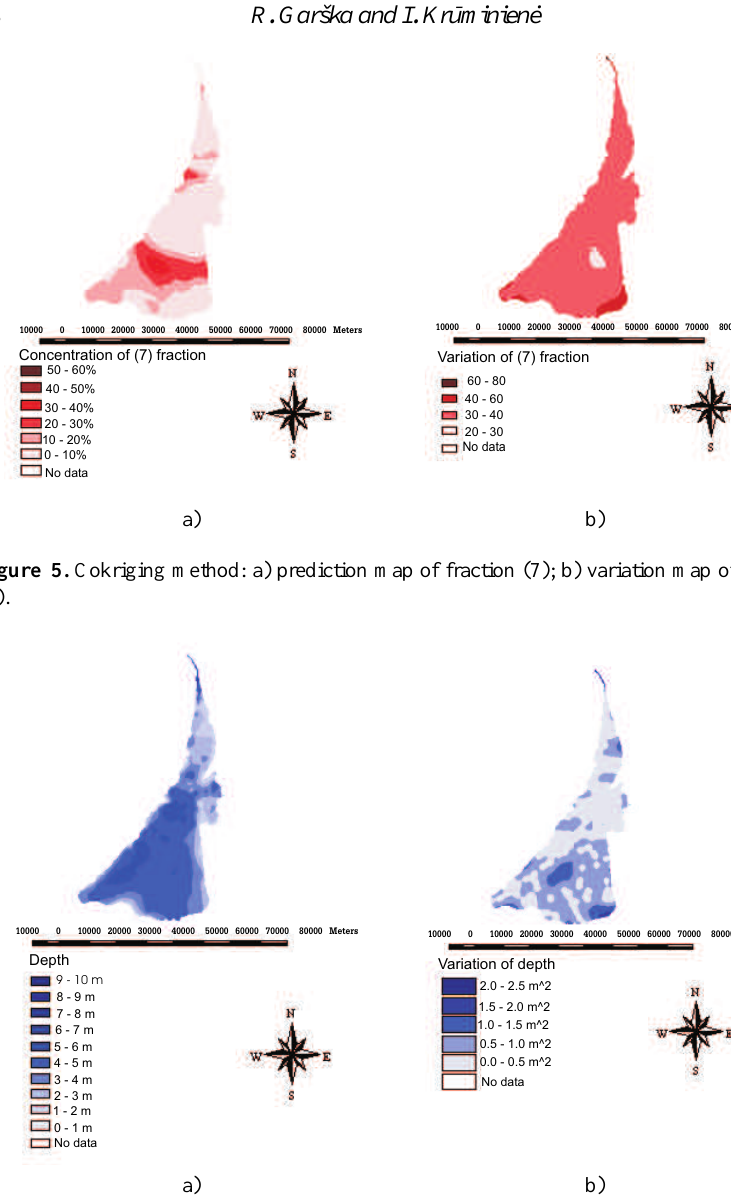
Figure 6. Kriging method: a) prediction map of depth; b) variation map of